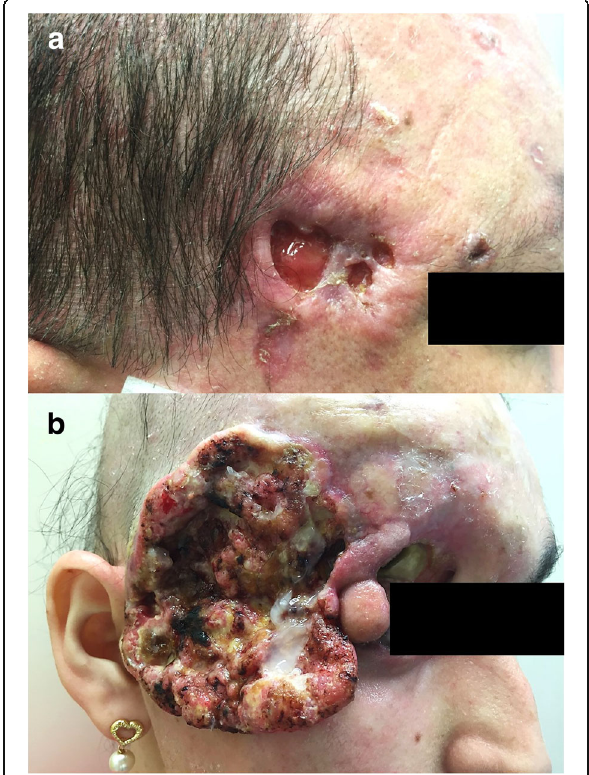
Fig. 2 Examples of malignant skin lesions in epidermodysplasia verruciform a Ulcerated squamous cell carcinoma in the temporal region. b Invasive squamous cell carcinoma of fast growing after adjuvant